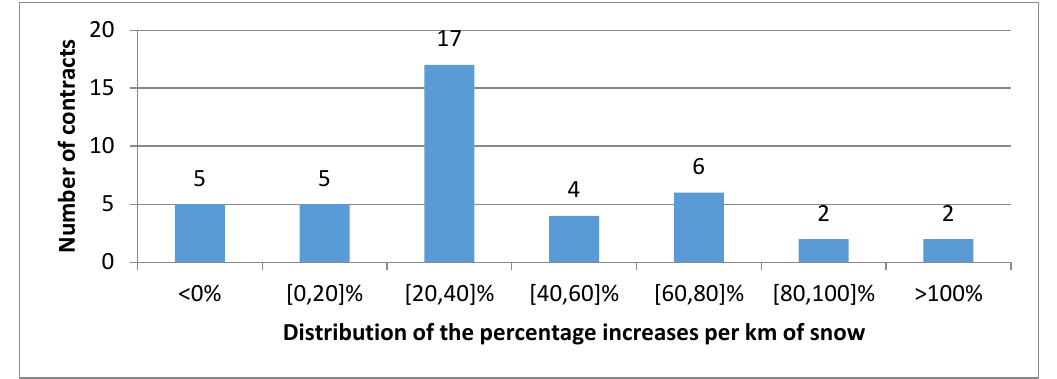
Figure 2. Distribution of the percentage increases per km of snow, 2016–2017 compared to 2015–2016 (actual price paid). Source: own processing using SPSS 23 software.